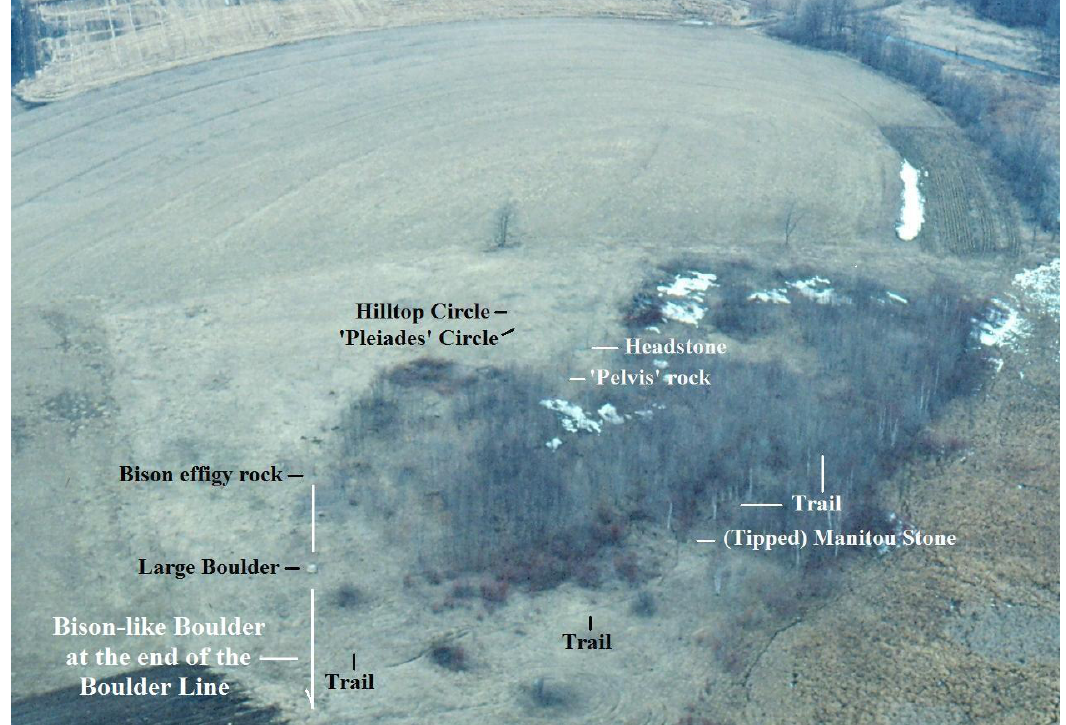
Figure 4. Aerial photograph of the Starman hill with the hilltop circle, the ‘Pleiades’ circle, the Starman headstone, pelvis rocks and other site features identified (Figure 2). View is looking approximate